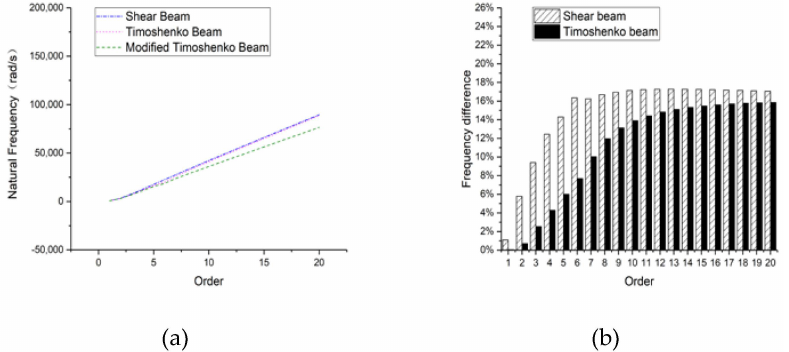
Figure 11. Natural frequencies of the 4-m-long beam: ( a ) overall frequency curve and ( b ) frequency di ff erence compared with a modified Timoshenko beam.